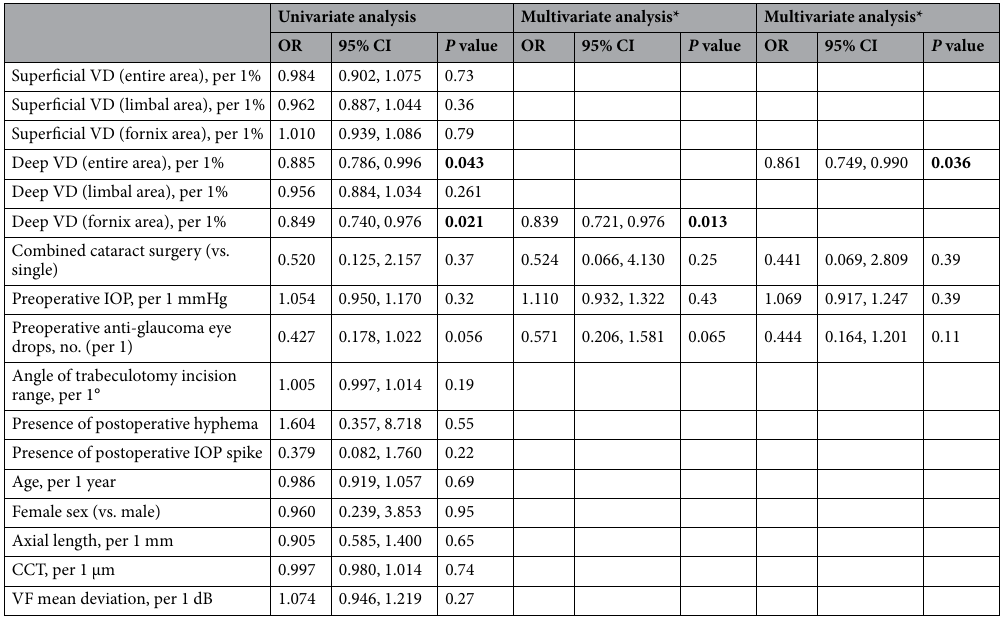
Table 3. Logistic regression analyses investigating factors associated with surgical success (N = 37). Statistically significant values ( P < 0.05) are shown in bold. CCT = central corneal thickness; CI = confidence interval; IOP = intraocular pressure; OR = odds ratio; VD = vessel density; VF = visual field. *Multivariate analysis for combination with cataract surgery, preoperative IOP, and all variables with P < 0.1 in a univariable regression model. The deep VD in the fornix area and that in the entire area were separately analyzed because of the